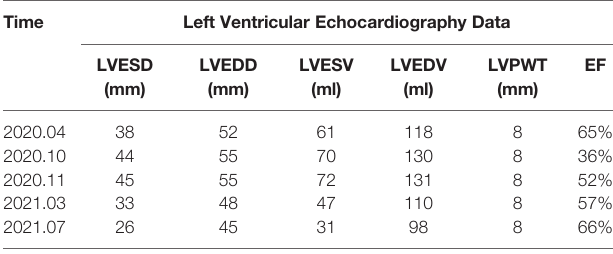
TABLE 3 | The left ventricular echocardiography data at cardiac failure and during recovery treatment. Time Left Ventricular Echocardiography